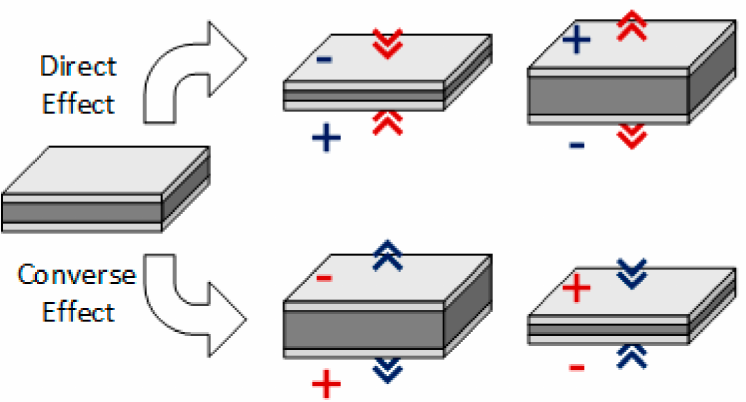
Figure 2. Simplified diagram of the direct and converse piezoelectric effect outcome (blue) due to different mechanical or electrical causes